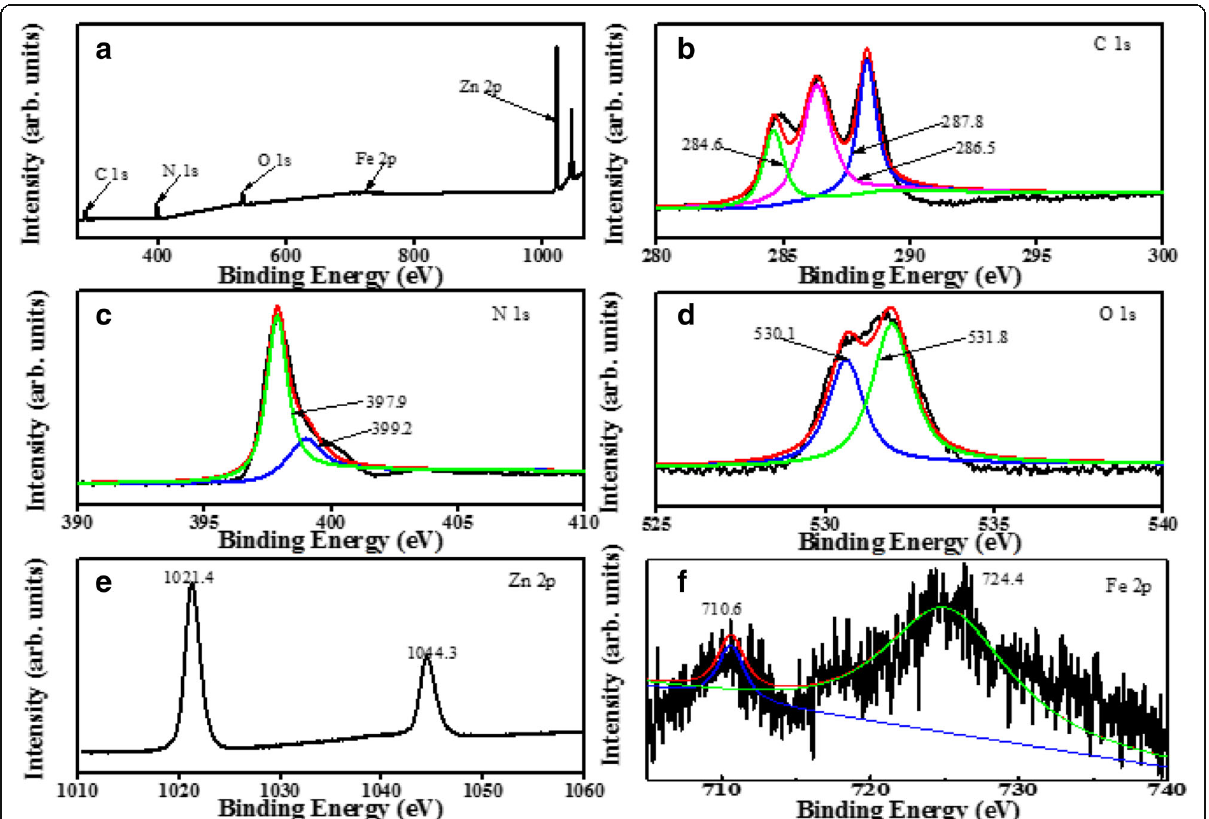
Fig. 4 XPS spectra of the synthesized ZnO/Fe 3 O 4/ g-C 3 N 4 -50%: a survey of the sample, b C 1s, c N 1s, d O1s, e Zn 2p, and f Fe 2p